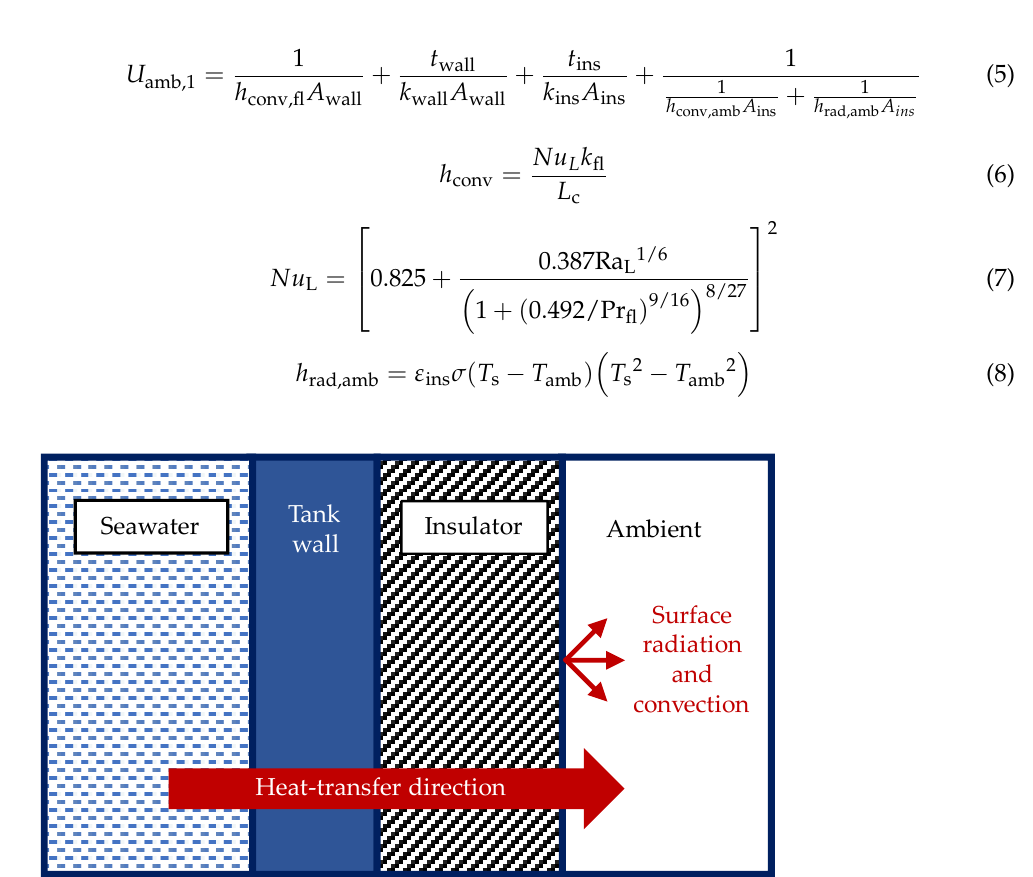
Figure 7. Heat transfer from the fluid inside the tank to the ambient air. In these equations, h conv,fl is the convective heat-transfer coefficient of the fluid in the tank, h conv,amb is the convective heat-transfer coefficient at the ambient air and insulator interface, A wall is the heat-exchange area of the tank wall, A ins is the heat-exchange area of the insulator, t wall is the thickness of the tank wall, t ins is the thickness of the insulator, k wall is the thermal conductivity of the tank wall, k ins is the insulator thermal conductivity, Ra L is the Rayleigh number, Pr fl is the Prandtl number of the fluid inside the tank, h rad,amb is the radiative heat-transfer coefficient at ambient, ε ins is the emissivity of the insulator, σ is the Stefan–Boltzmann constant, and T s is the surface temperature of the insulator.